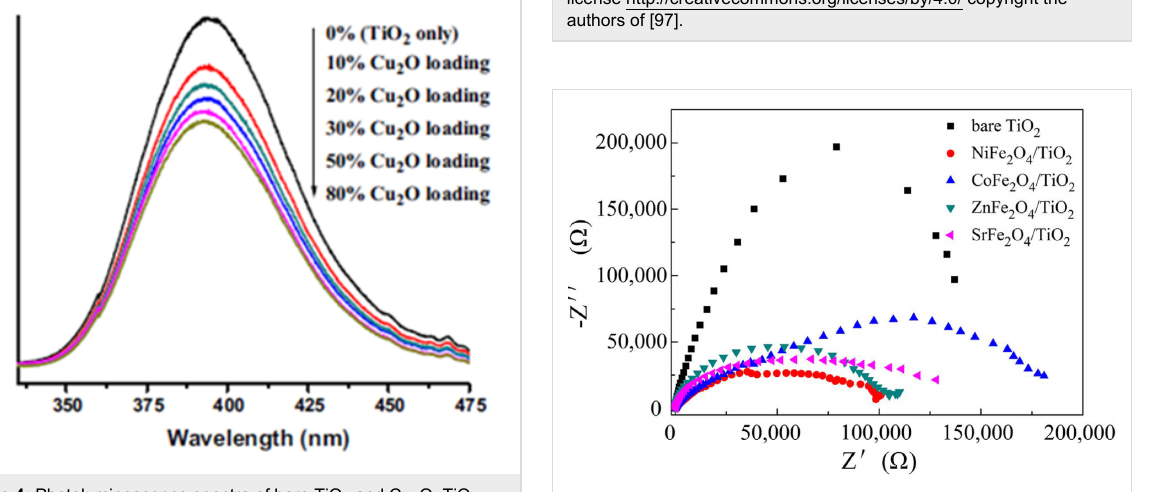
Figure 4: Photoluminescence spectra of bare TiO 2 and Cu 2 O–TiO 2 samples. Reprinted from [96], copyright 2016 Springer Science+Busi- ness Media.